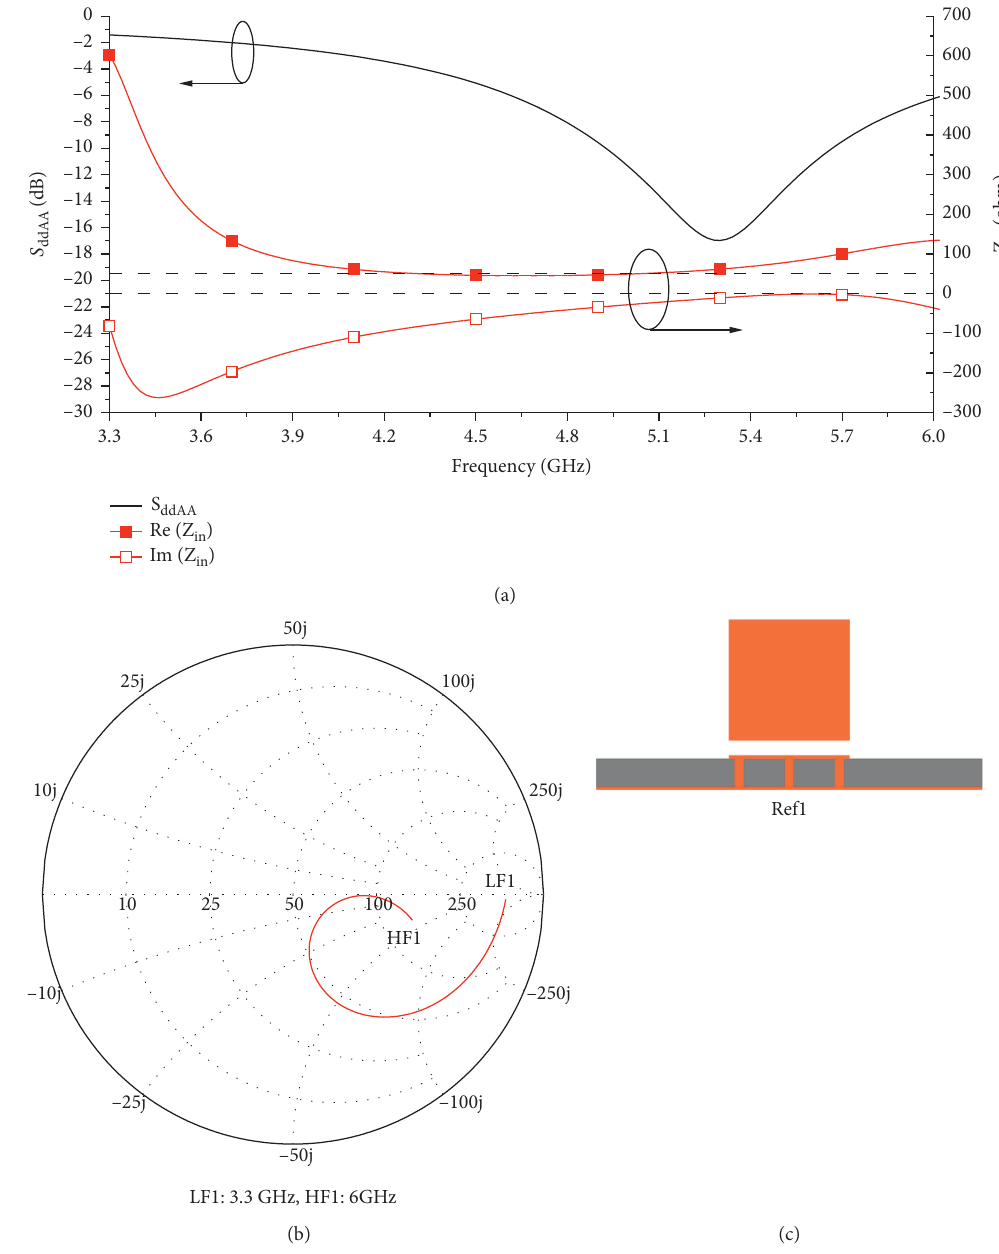
Figure 3: Simulated ( S ) ddAA , Z in , and Smith chart of the single-layer patch